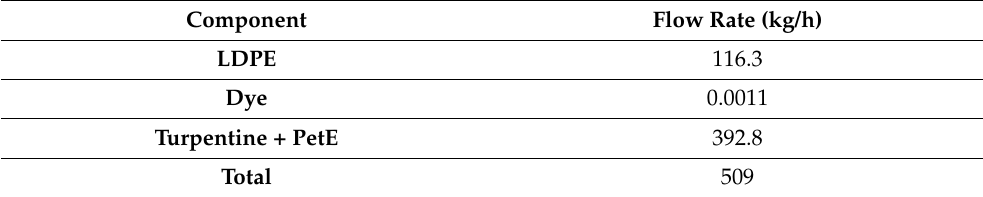
Table 5. Feed properties for the filtration process.